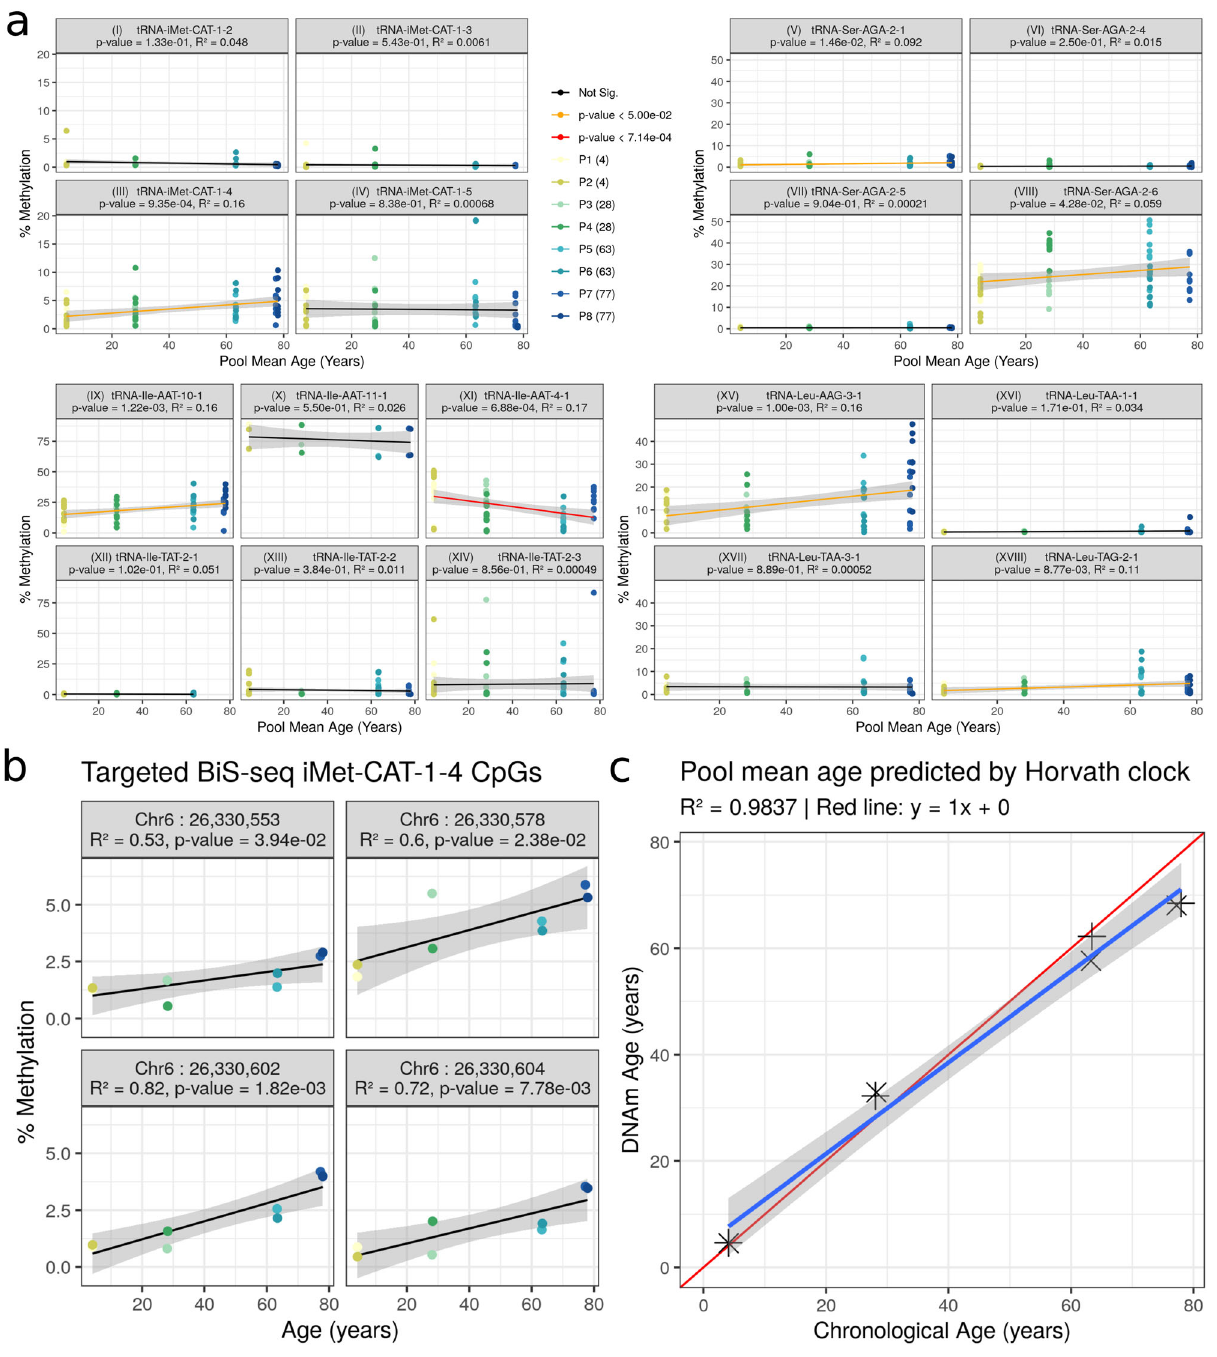
Fig. 5 Comparison of age-related hypermethylating tRNA genes to closely related tRNA genes using targeted bisul fi te sequencing (BiS-seq). a Combined CpGs within tRNA loci results (experiment-wide Bonferroni p = 7.14 × 10 − 4 ); i-iv, Comparison of select tRNA-iMet-CAT loci: Hypermethylation is speci fi c to iMet-CAT-1-4 (iii) not other isodecoders (i, ii, & iv); v-viii, Comparison of select tRNA-Ser-AGA loci: hypermethylation is speci fi c to Ser-AGA-2-6 A (viii) and to a lesser extent Ser-AGA-2-1 (v), whilst not other isodecoders (vi, vii); ix-xiv, Comparison of select tRNA-Ile loci: Hypermethylation is speci fi c to Ile-AAT-10-1 (ix), Ile-AAT-4-1 (xi) displays hypomethylation contrary to previous MeDIP fi ndings, Ile-TAT-2-2 & 2-3 lack hypermethylation (previously non-signi fi cant in blood-corrected MeDIP, although signi fi cant in uncorrected), whilst no change in Ile-AAT-11-1 (x) and Ile- TAT-2-1 (xii); xv-xviii, Comparison of select tRNA-Leu loci: Hypermethylation in Leu-AAG-3-1 (xv) consistent with 450k and Leu-TAG-2-1 (xviii) consistent with MeDIP, whilst no change in Leu-TAA-1-1 (xvi) & Leu-TAA-3-1 (xvii). b tRNA-iMet-CAT-1-4 Individual CpG analysis: 4 CpGs within this tRNA show consistent methylation increases (all p < 0.05). c Mean chronological age is tightly correlated with DNAm Horvath clock 11 predicted age for the 8 pooled samples (see Table 1 for pool details). All p values are for F-tests from simple linear regression, Error bands represent the SEM. Source data for these plots are provided as a Source Data fi le and results for all tRNAs covered are provided in supplementary data